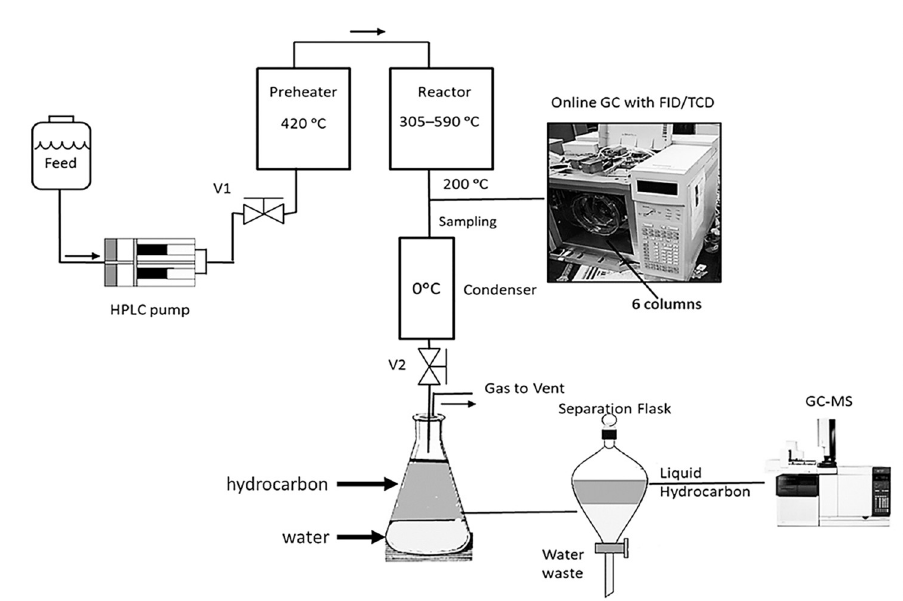
Fig 2. Schematic diagram of the oligomerization